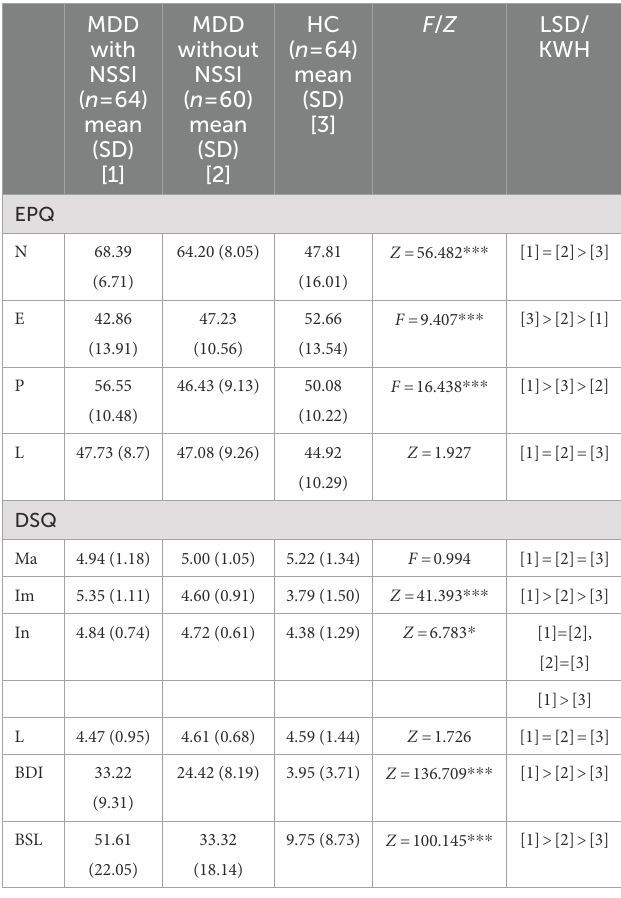
TABLE 2 Psychological measurements between MDD with NSSI group, MDD without NSSI group and HC group. MDD with